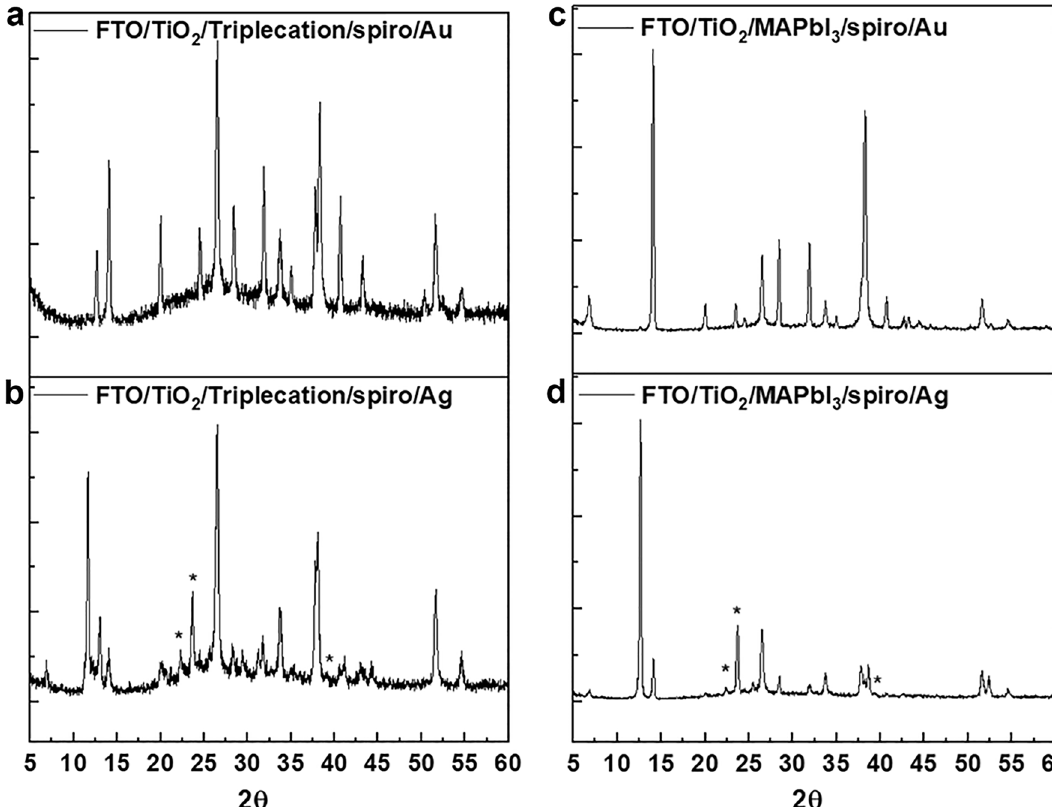
Figure 5. XRD of aged PSCs stored in ambient condition over 10 days in a petri dish without encapsulation at 25 °C and RH ~ 30 to 40%. XRD spectra of: ( a ) triple cation with Au; ( b ) triple cation with Ag; ( c ) MAPbI 3 with Au; ( d ) MAPbI 3 with Ag. Asterisks in ( b ) and ( d ) indicate the diffractions at 2θ = 22.3°, 23.8°, and 39.2° corresponding to the (100), (002), and (111) peaks of β-AgI, respectively. These peaks indicate the rapid formation of AgI in Ag based PSCs, while in ( a , c ), the formation of AuI is almost negligible since the characteristic AuI diffraction peaks were absent from our spectra, as noted in the Supporting Information of Ref. 30